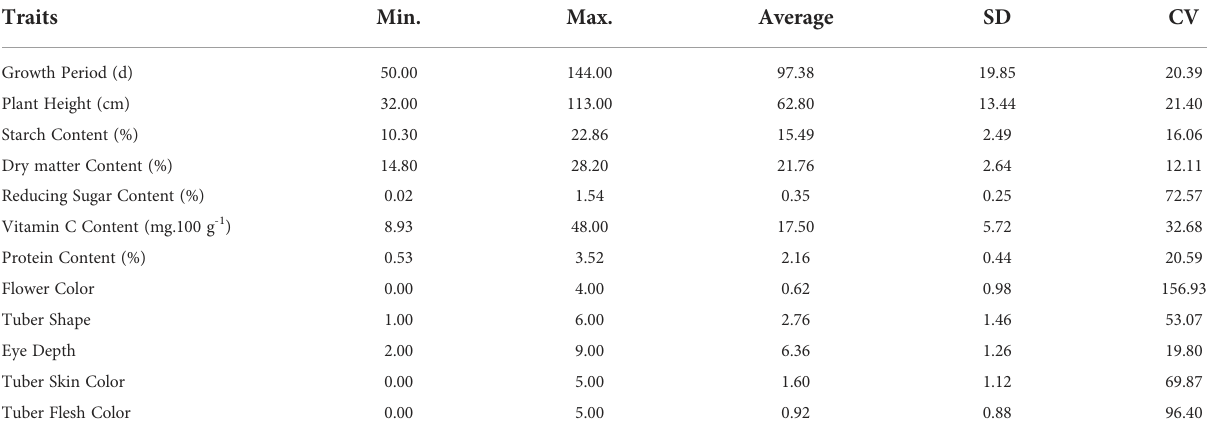
TABLE 1 12 phenotypic variation parameters of 149 potato cultivars in China. Traits Min.